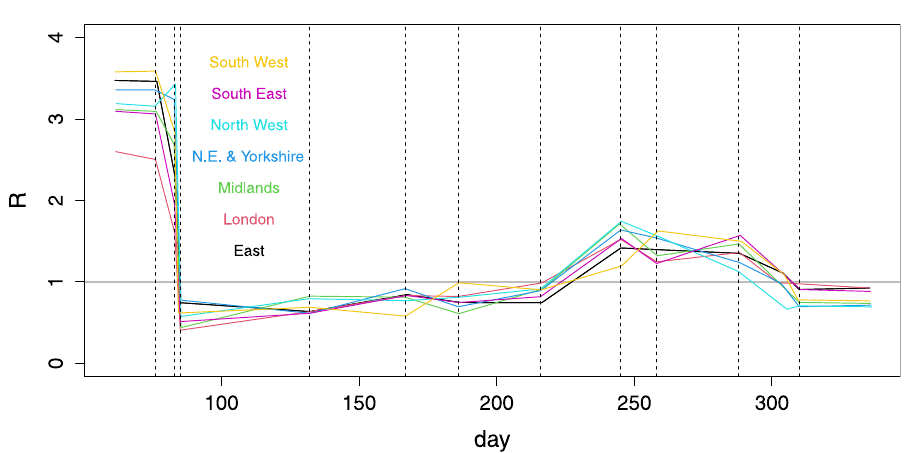
Fig 1. Estimates of R by English region against day of year, as reported in [1]. The plot is based on data digitized from Fig 1 of [1]. Uncertainties were not reported. The vertical lines mark model breakpoints at: 16th March movement restrictions (work from home advice), 23rd March lockdown announcement, 25th March ‘Lockdown in full effect’, May 11th initial easing, June 15th shops re-open, July 4th restaurants re-open, August 3rd eat-out-to-help- out scheme, September 1st schools open, September 14th rule of 6, October 14th Tier system, November 5th Lockdown. The kinks preceding November 5th are at a further model breakpoint. Prior to the first lockdown the following interventions occurred for which no breakpoints have been imposed: public information campaign, March 4th; symptomatic self isolation 13th; school and hospitality closures 20th. Full lockdown (stay at home orders and shutting down of much ‘non-essential’ activity) came into effect on 24th March, having been announced at 20:30 on 23rd March.